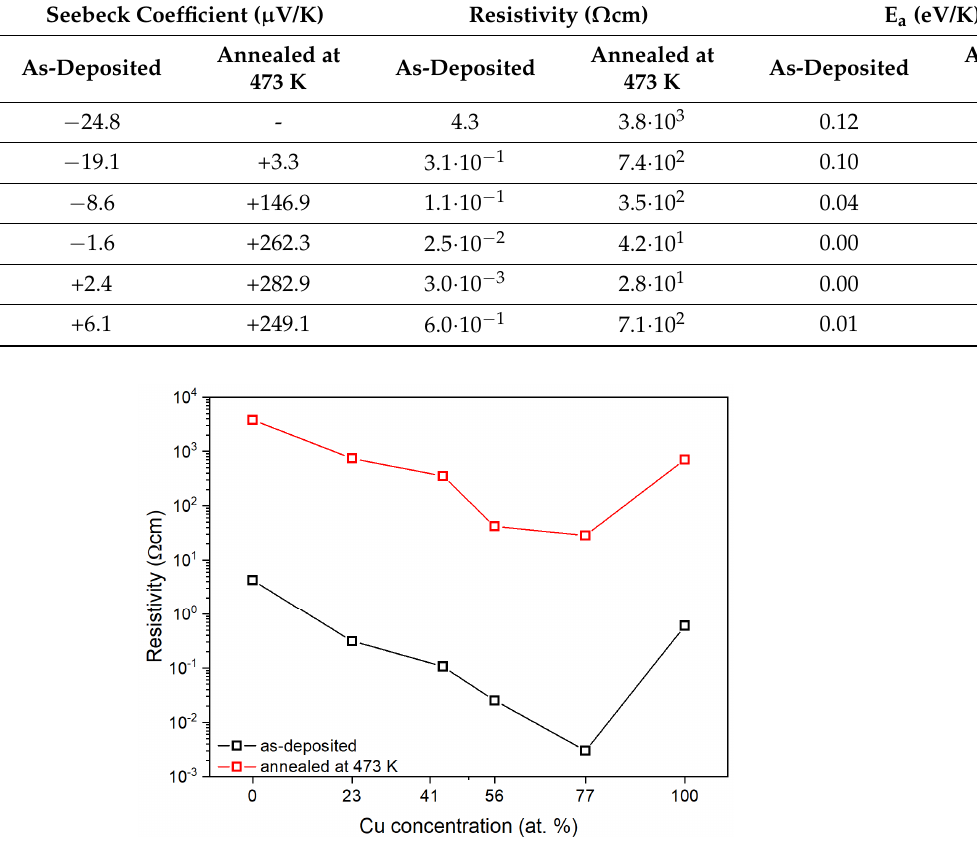
Figure 6. Resistivity changes depending on elemental composition and annealing temperature. Table 3. Electrical parameters of as-deposited and annealed at 473 K (CuTi)Ox thin films